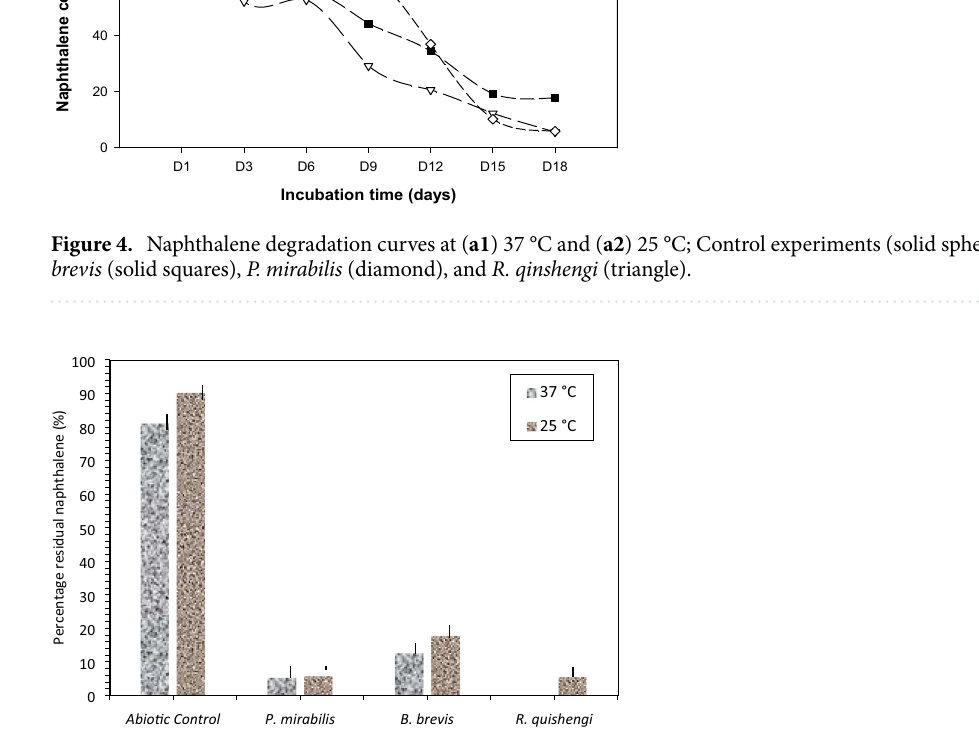
Figure 5. Residual naphthalene in cultures at 37 °C and 25 °C after 18 days, vertical bar represents error